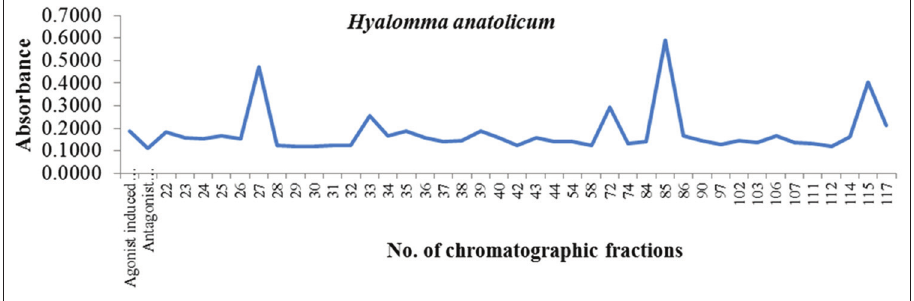
Figure-2: Effects of Hyalomma anatolicum salivary gland protein fractions on bovine platelet aggregation stimulated with thrombin.